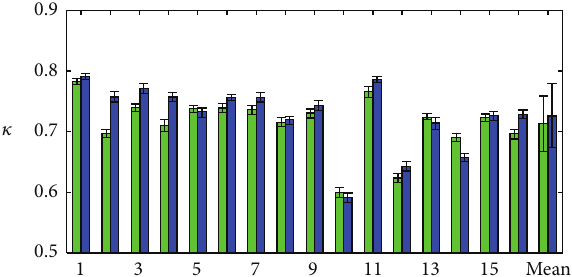
Figure 8: Kappa scores are shown for each of the 16 patients examined, with mean and standard deviation shown on the right. Green/left of pair: typical landmark matching; blue/right of pair: GDAS landmark matching.